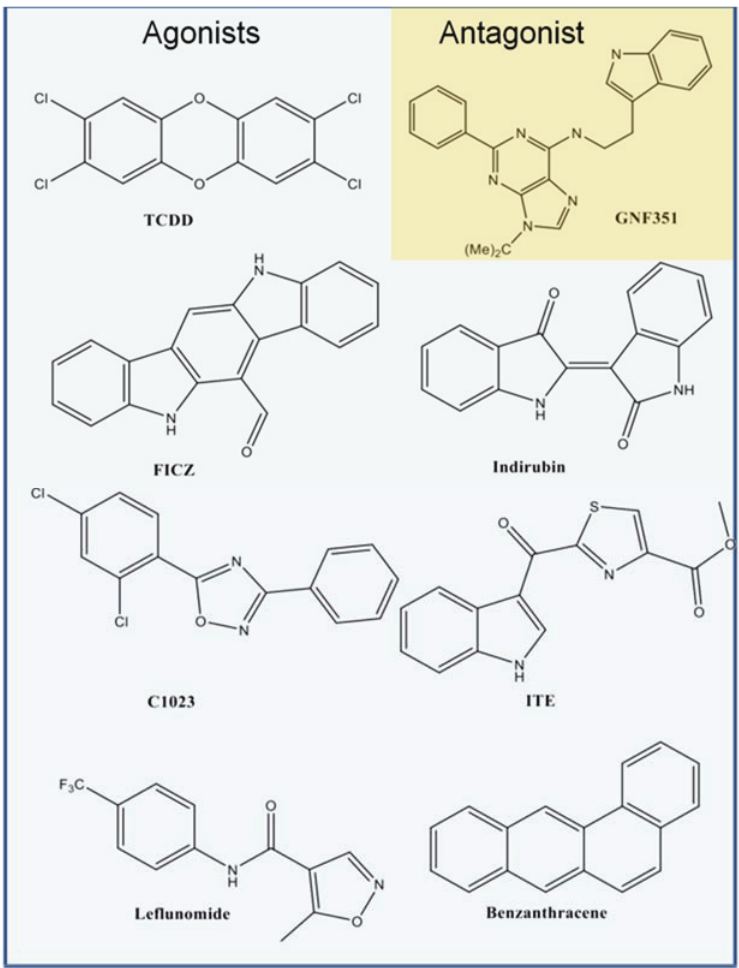
Figure 1. Chemical structures of aryl hydrocarbon receptor (AHR) ligands. The chemical structures of selected agonists from the benchmarking database are shown in blue, and the structure of antagonist GNF351 is shown in